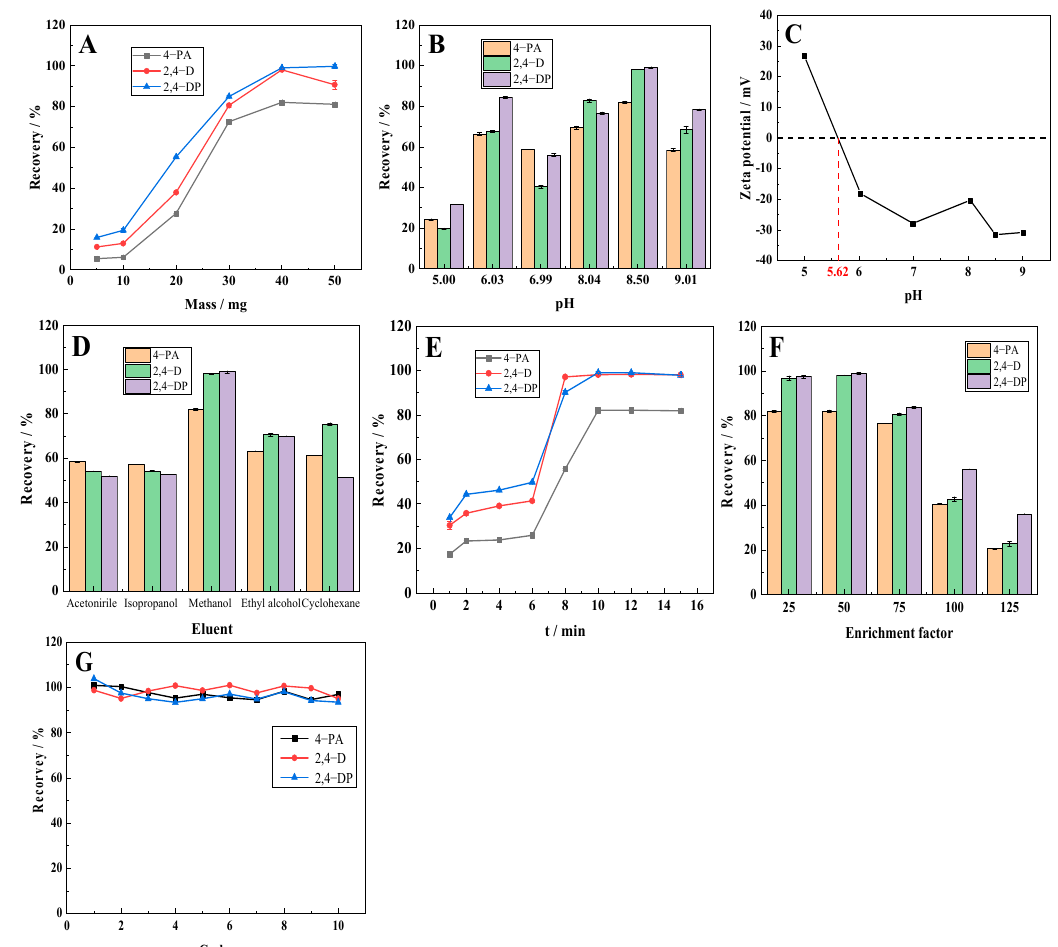
Figure 8. The effect of dosage ( A ), pH ( B ), Zeta potential ( C ), eluent type ( D ), adsorption time ( E ), enrichment factor ( F ), and cycles ( G ) on three phenoxy carboxylic acid herbicides.